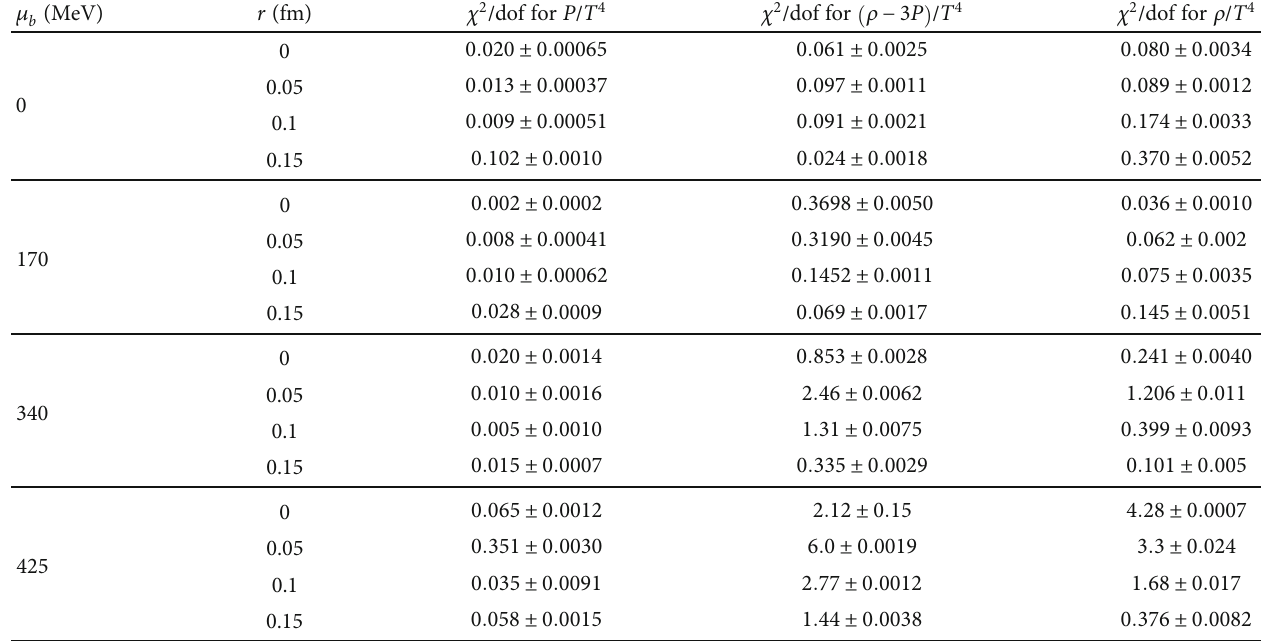
Table 1: χ 2 /dof statistic for the normalized pressure P / T 4 , trace anomaly ð ρ − 3 P Þ / T 4 , and normalized energy density ρ / T 4 calculated in our statistically corrected hadron resonance gas (HRG) model confronted to the corresponding lattice data taken from Ref. [66, 67], at four values = 0, 170, 340 , and 425MeV of baryon chemical potential μ b